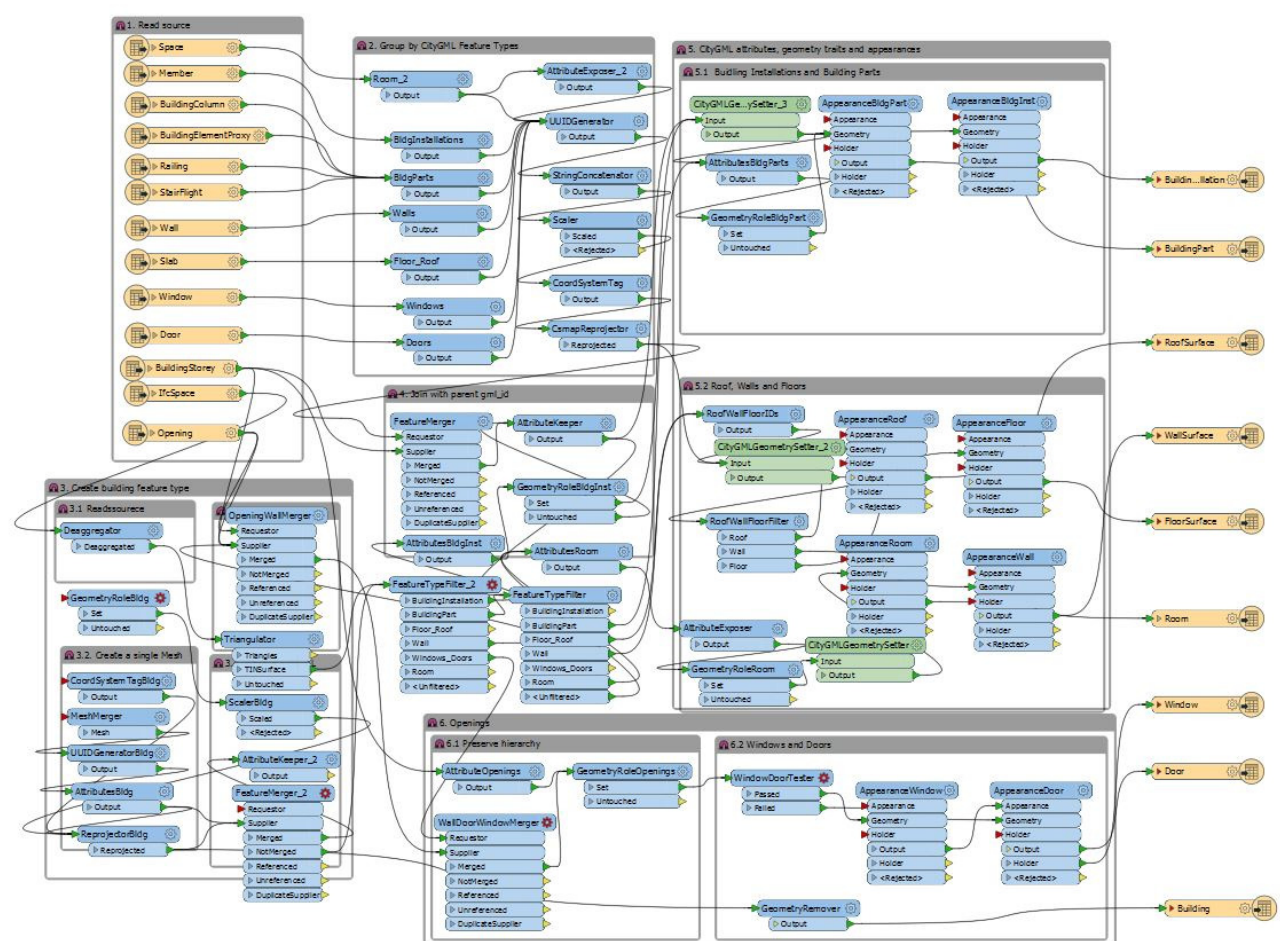
Figure 13. FME algorithm for IFC To CityGML